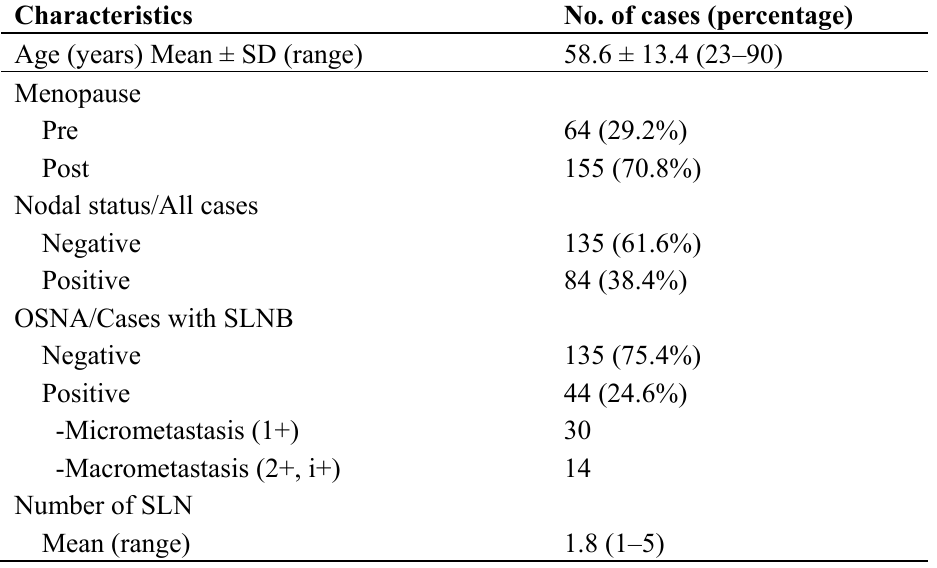
Table 1. Patients’ characteristics in 219 breast cancer